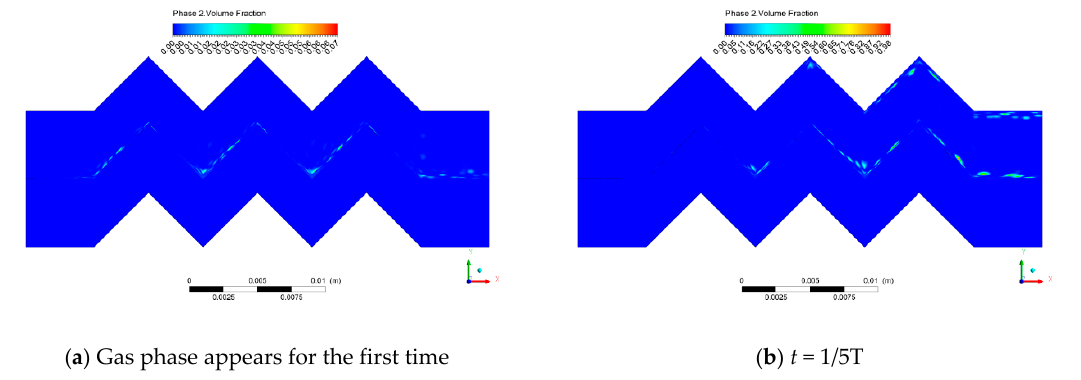
Figure 6. Cont. Figure 6. Cont